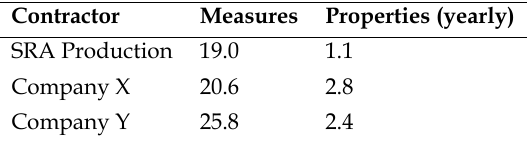
Table 3. Potential contractors submitted offer to VMN (in million